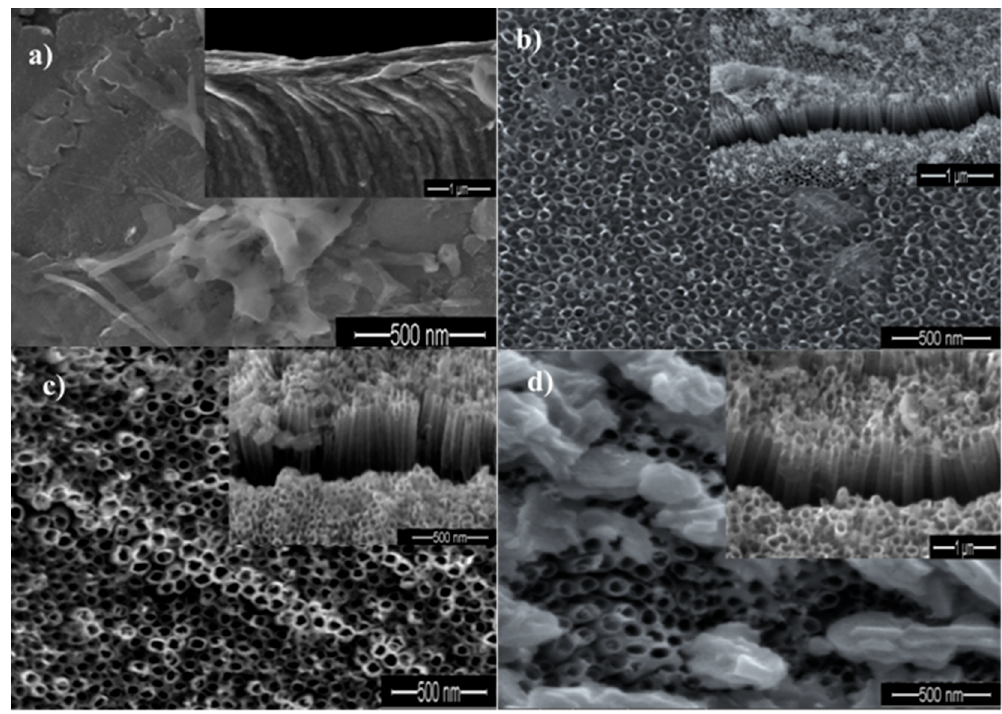
Figure 2. SEM images of TiO 2 nanotubes fabricated by the anodization of Ti foil at 30 V for different times: ( a ) 30 s; ( b ) 10 min; ( c ) 20 min and ( d ) 60 min.